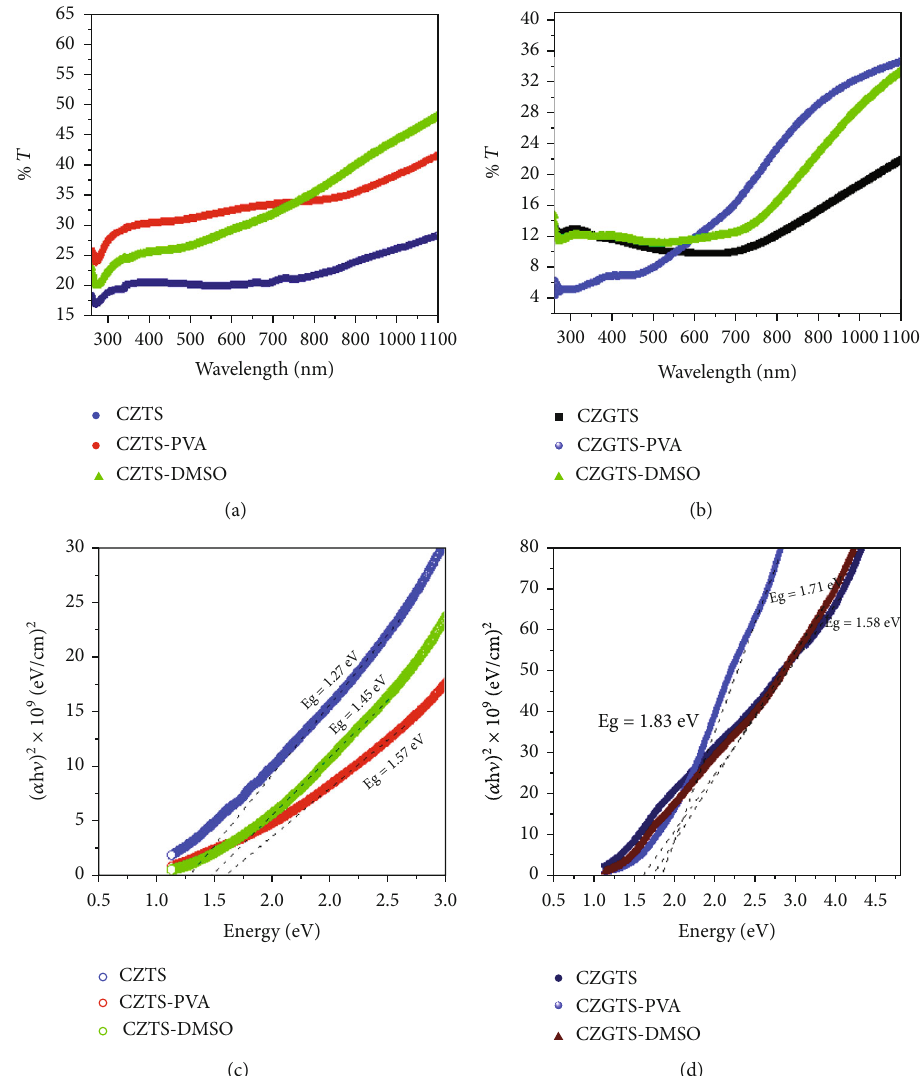
Figure 7: (a – d) UV/visible transmission and Tauc plots for the CZTS, CZTS-PVA, and CZTS-DMSO and CZGTS, CZGTS-PVA, and CZGTS-DMSO thin fi